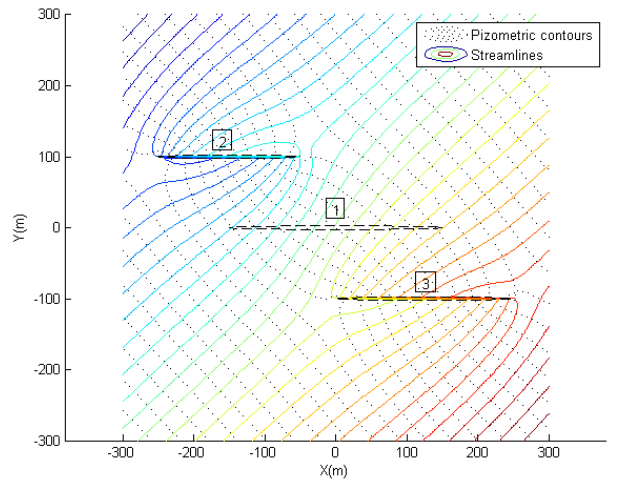
Figure 4. 3 fractures with different hydraulic conductivities, apertures and lengths having an angle of 45 ◦ in a uniform flow